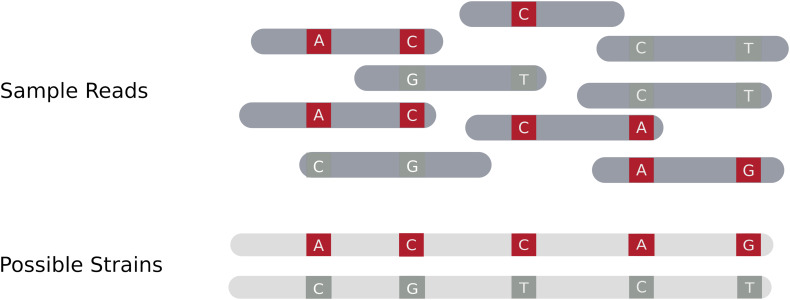
Assembly of multiple distinct strains from a read set. The blue areas in the sample reads represent regions where the strains have identical sequence. Variant locations in the reads are denoted as red or dark gray stripes. Red variants originate from one haplotype, whereas dark gray variants originate from the other. The goal of an assembly based method is to resolve distinct strains based on the coverage and distribution of the read data, drawing on methods previously developed for resolving haplotypes.